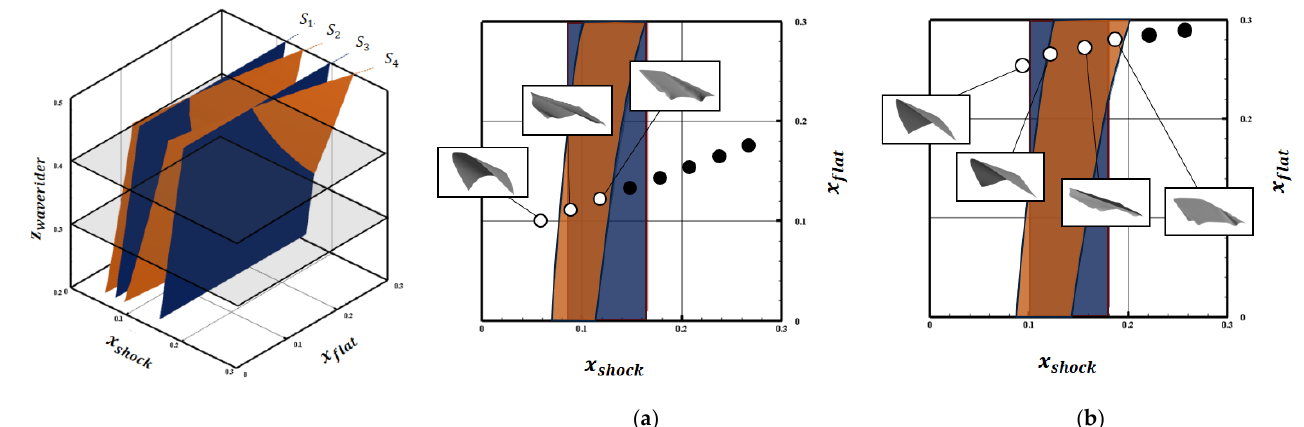
; ( b ) . 𝑧𝑧 𝑤𝑤𝑓𝑓𝑤𝑤𝑤𝑤𝑤𝑤𝑤𝑤𝑤𝑤𝑤𝑤𝑤𝑤 = 0.3 𝑧𝑧 𝑤𝑤𝑓𝑓𝑤𝑤𝑤𝑤𝑤𝑤𝑤𝑤𝑤𝑤𝑤𝑤𝑤𝑤 = 0.4